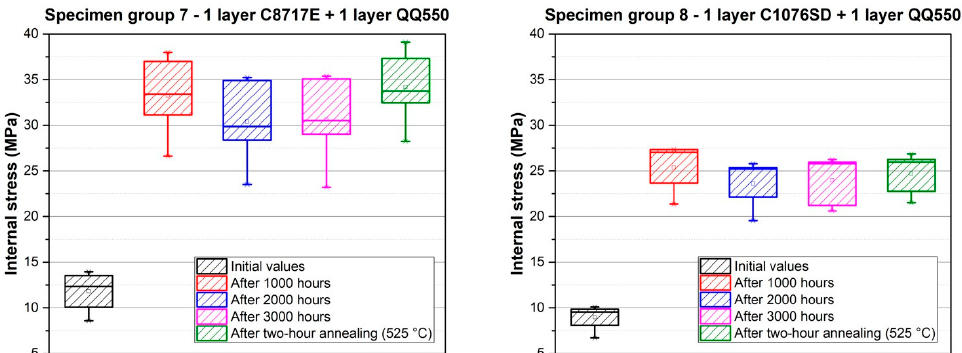
Figure 13. Internal stress changes over time for the combination of silver films and overglaze paste QQ550—specimen group 7 ( left ), and specimen group 8 ( right ).